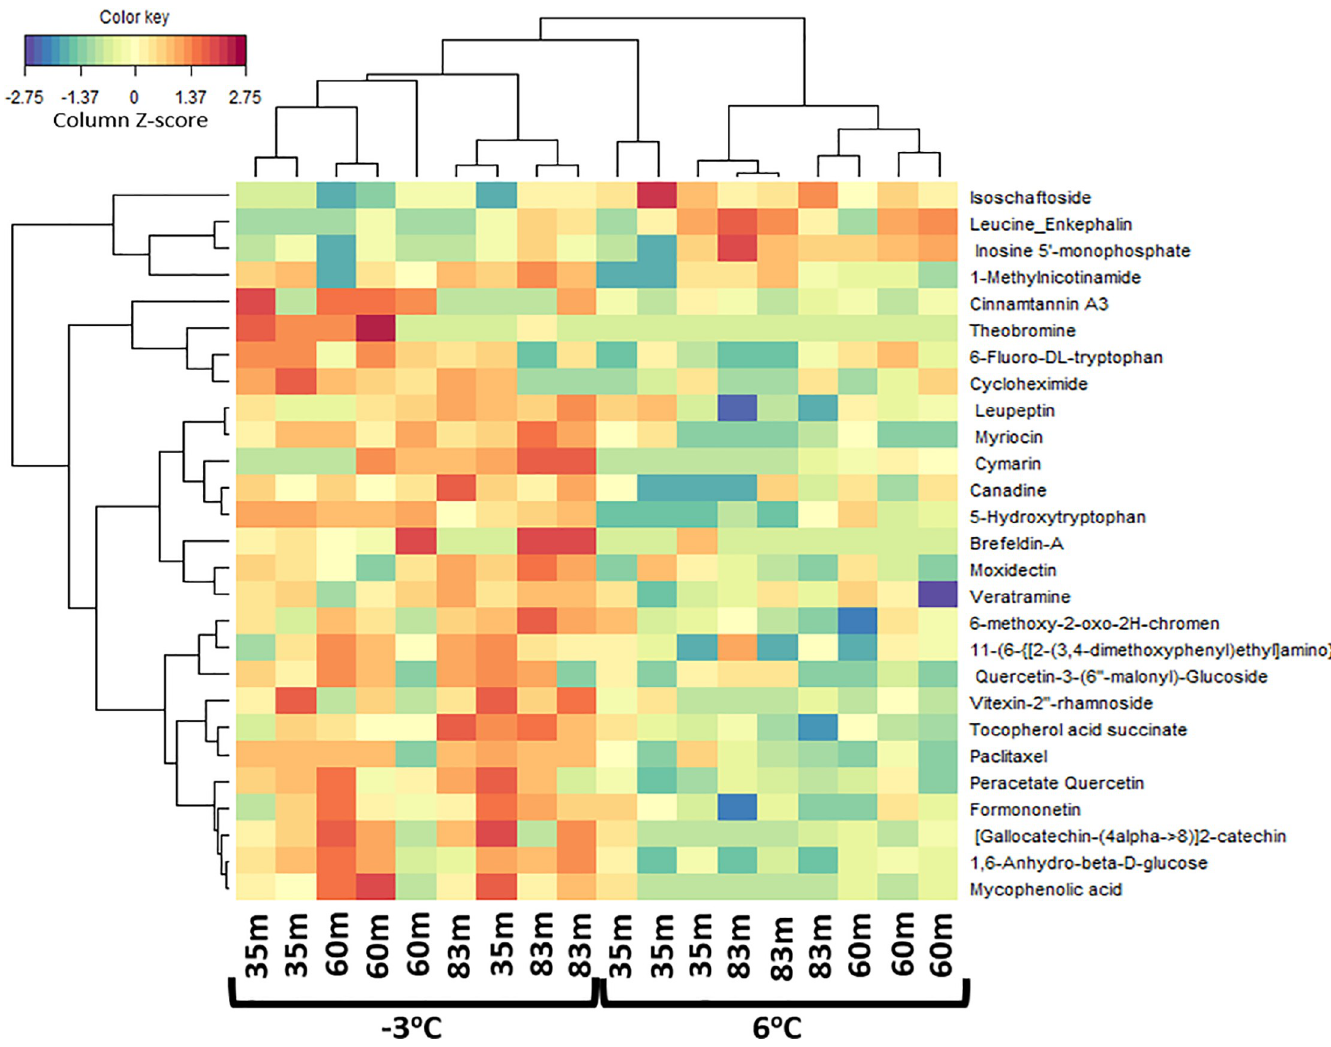
Fig 8. A heatmap illustrating from the hierarchical clustering analysis of metabolites in permafrost microbial cells at the three locations and thawed from -3 o C to 6 o C. The map shows a scaled Z-scores intensity values of 27 metabolites of the filtered dataset under the ESI+ mode. The negative (blue) value indicates an intensity that lies below the mean and the positive (red) values indicate an intensity that is above the mean. Metabolites “11-(6-{[2-(3,4-dimethoxyphenyl)ethyl]amino}” and “6-methoxy-2-oxo-2H-chromen” were abbreviated for “11-(6-{[2-(3,4-dimethoxyphenyl)ethyl]amino }-4-chloro-1,3,5-triazin-2-yl)-7” and